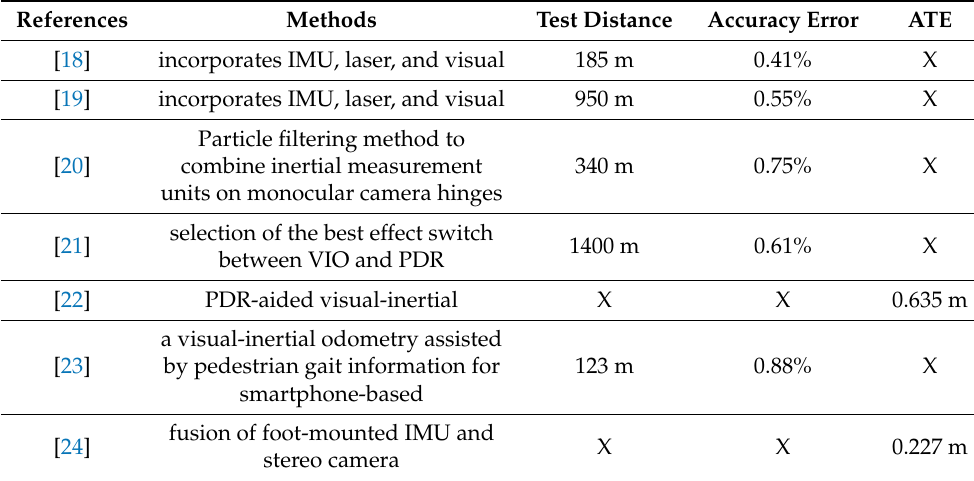
Table 1. Pedestrian positioning method and accuracy. X means not